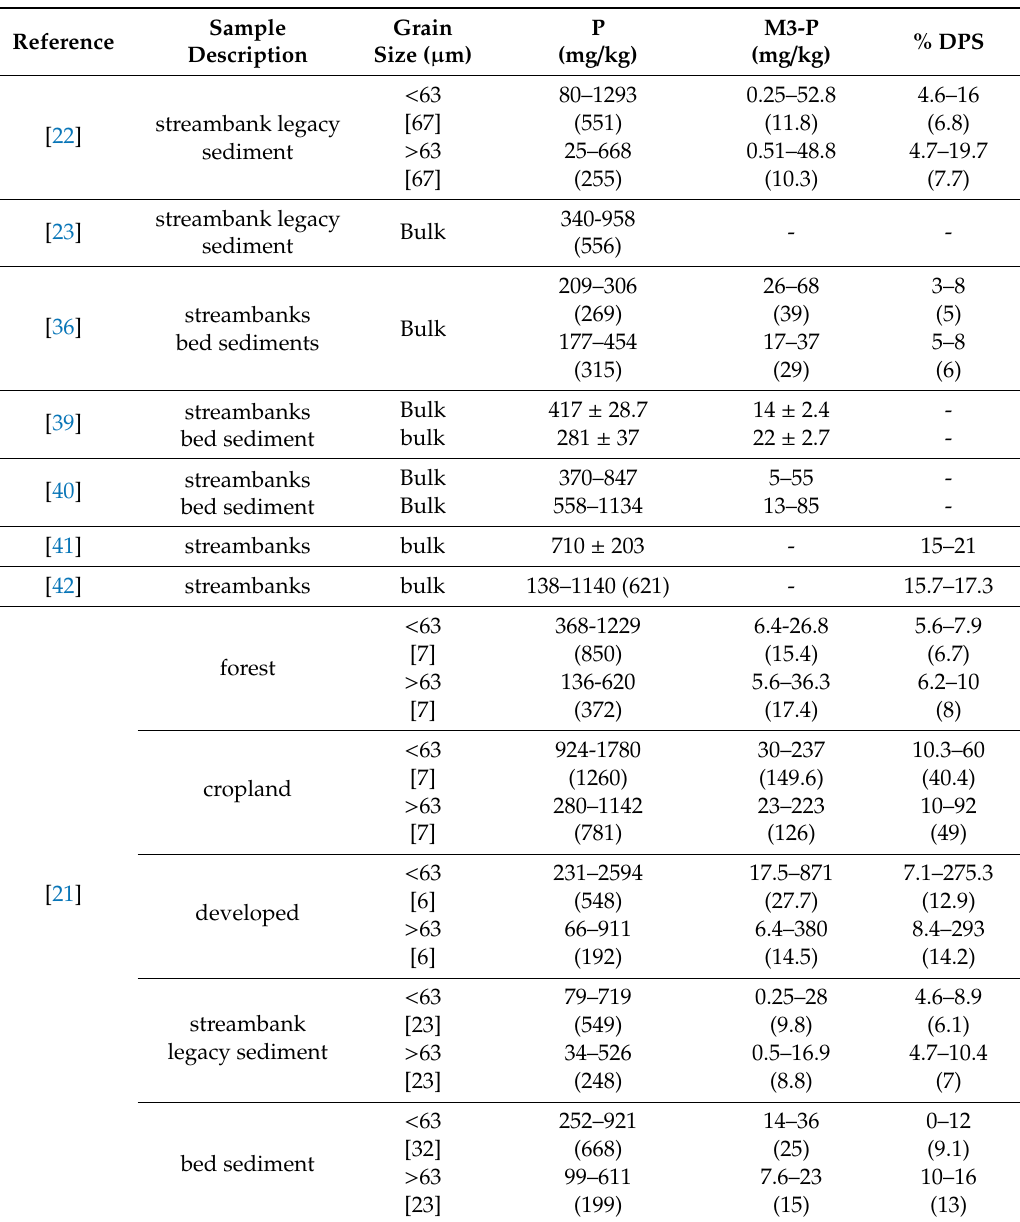
Table 1. Comparison of legacy sediment P concentrations against other soil / sediment sources. Comparisons are made for particle size class ( < 63 µ m: fine), coarse, and bulk sediments. Concentrations include a range of values and mean in brackets ( ). Where available, sample numbers are indicated in square brackets [ ]. Table modified from